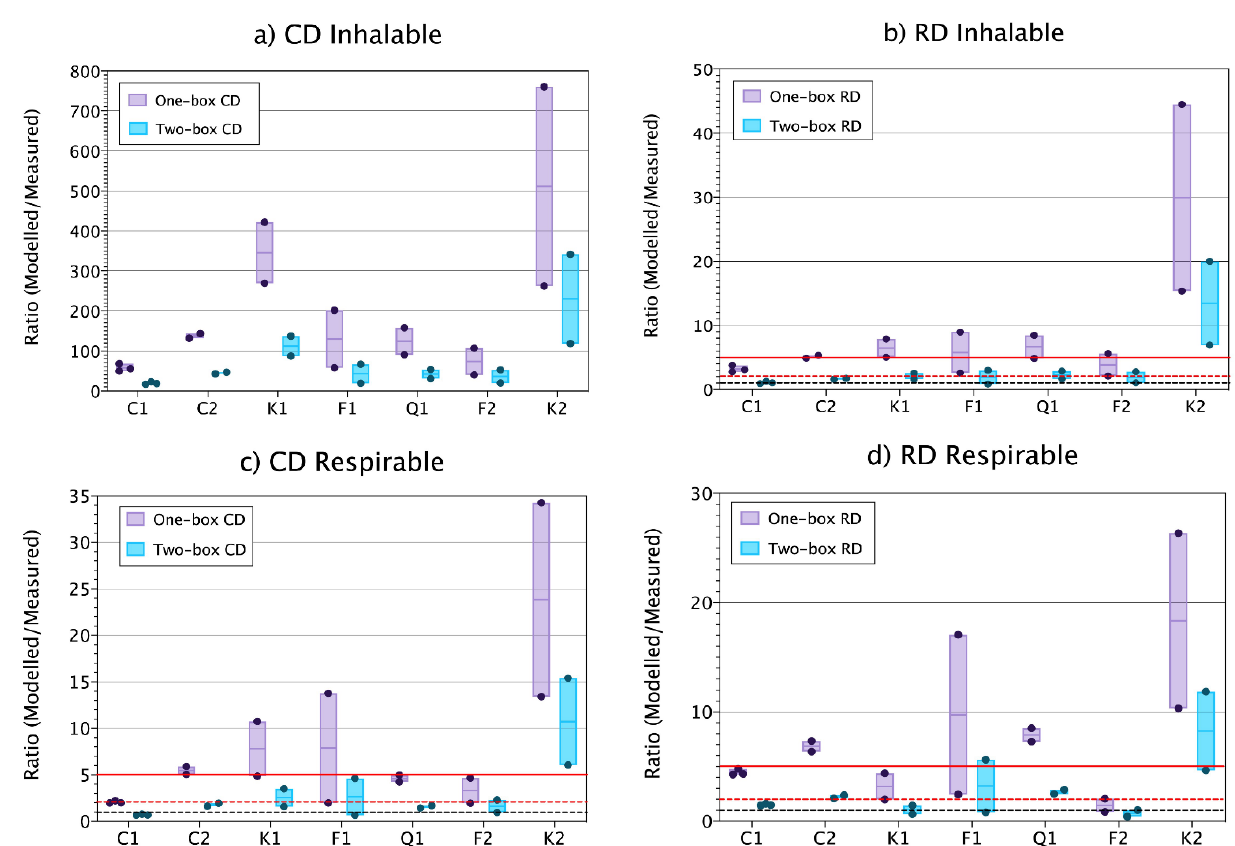
Figure 2. Vertical boxplot showing all materials one- (room) and two-box (FF) ratio modelled/measured ( a ) inhalable concentrations using CD DI as input, ( b ) using RD DI as input for the one-box model, ( c ) using CD DI as input for the two-box model, and ( d ) using RD DI as input for the two-box model. Ratios 1, 2 and 5 are marked as reference (red solid line, red dashed line and black dashed lines, respectively). The solid coloured line within the box indicates the median value, and the limits of the box indicate min and max values. Coloured dots represent the individual replicate values. Modelling parameters: L EV and β fixed at 70% and 5 m 3 min −1 , respectively.